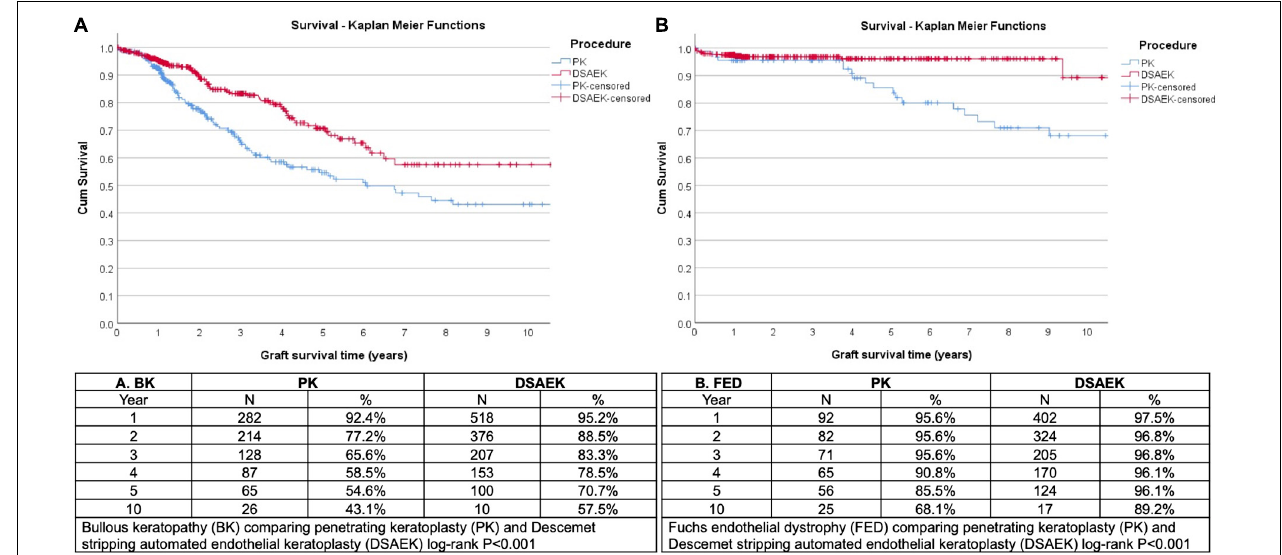
FIGURE 2 | Kaplan Meier graft survival curves demonstrated superior 10-year graft survival comparing Descemet stropping automated endothelial keratoplasty (DSAEK) to penetrating keratoplasty (PK) in eyes (N = number of grafts analyzed) with (A) bullous keratopathy (BK, log-rank P < 0.001) and (B) Fuchs endothelial dystrophy (FED, log-rank P <